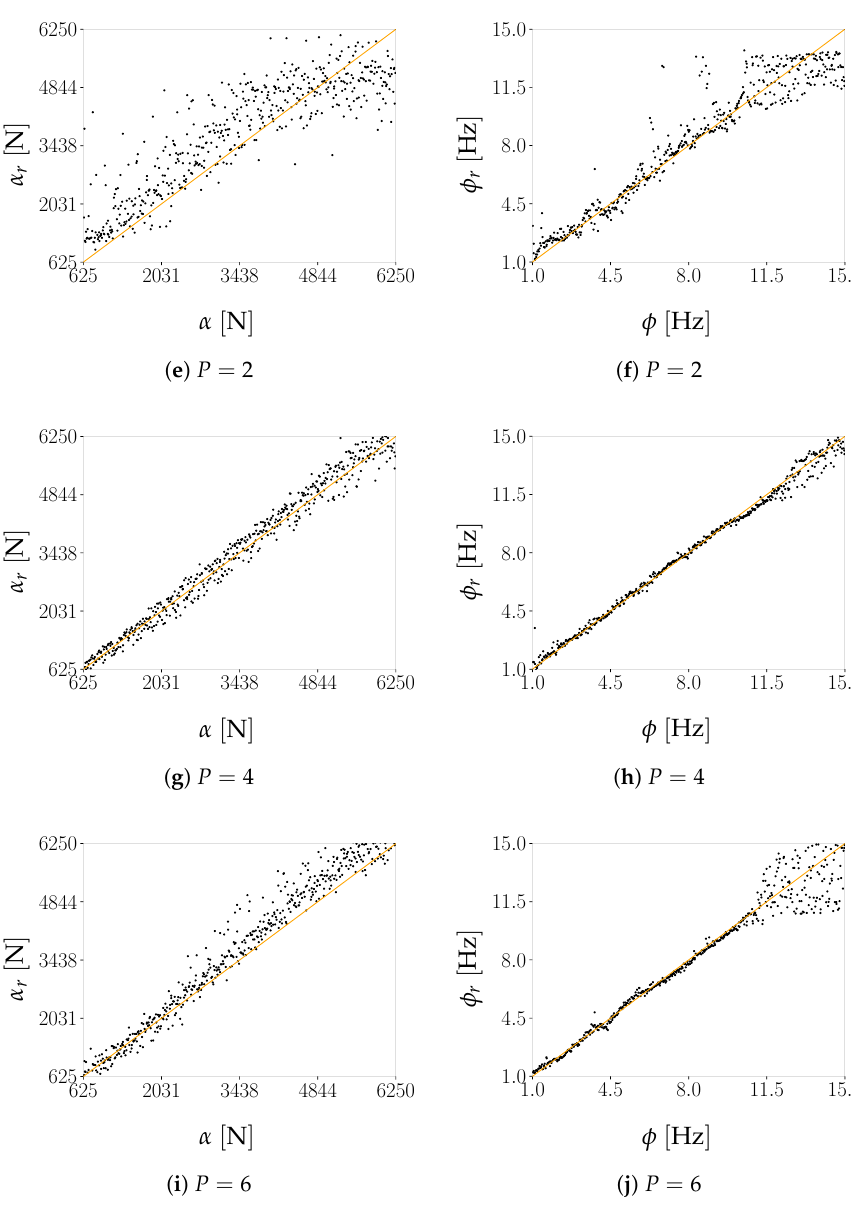
Figure 21. Two-storey shear building, configuration A, test set. Parity plots showing the regression outcomes for the load amplitude α ( left column ) and the load frequency φ ( right column ), at varying dimension P of the latent representation, against the ground-truth data. Table 4. Two storey shear building, configuration A, test set. RMSE and correlation coefficient R 2 of the regression outcomes for the load amplitude α and the load frequency φ , at varying dimension P